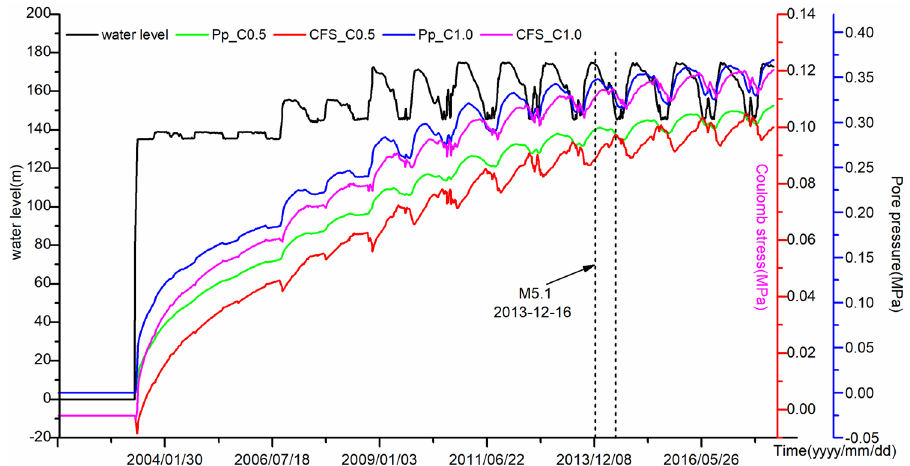
regions.Figure 8. Water level changes (black solid line), diffused pore pressures (green and blue lines) and coulomb stress (red and pink lines) associated with M5.1 earthquake on 16, December, 2013 for different hydraulic conductivity